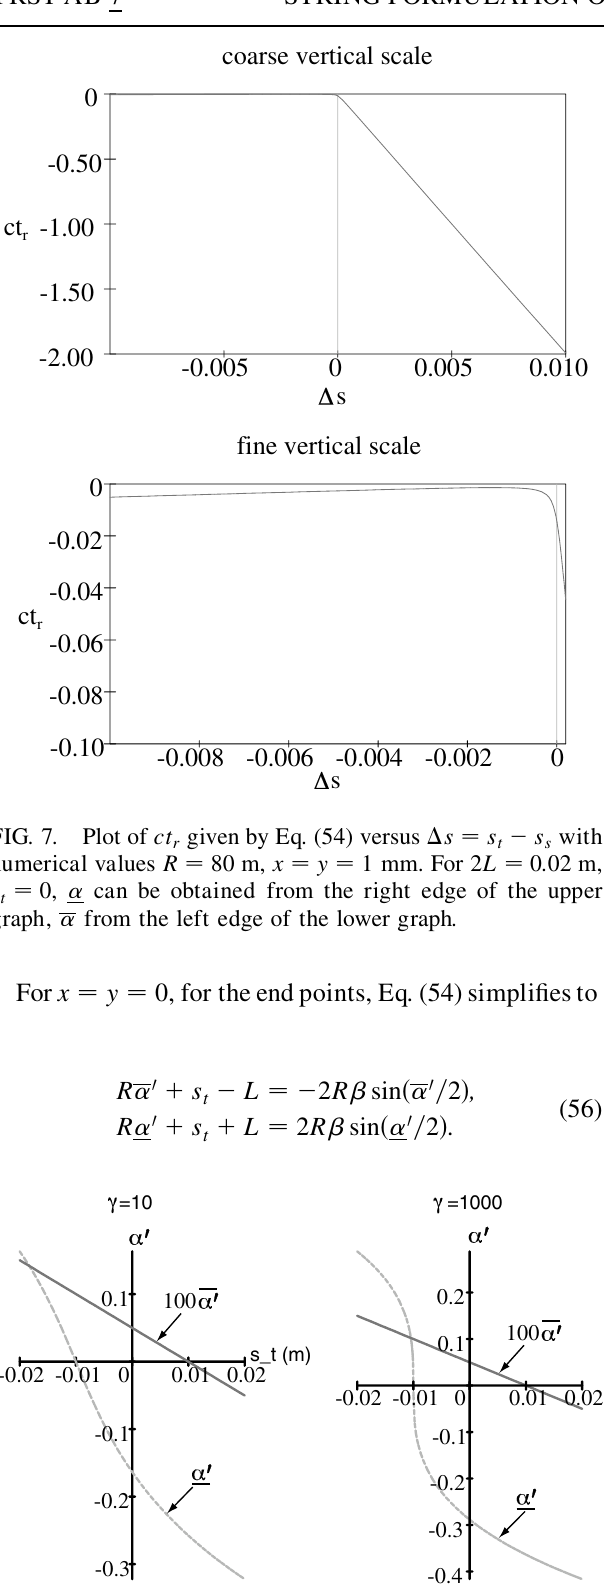
. R (cid:1) 10 m , L (cid:1) t